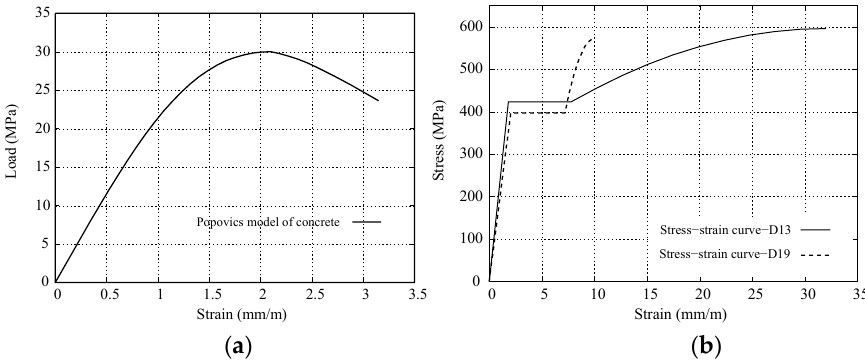
Figure 7. Analytical stress–strain model: ( a ) concrete; ( b ) reinforcement.